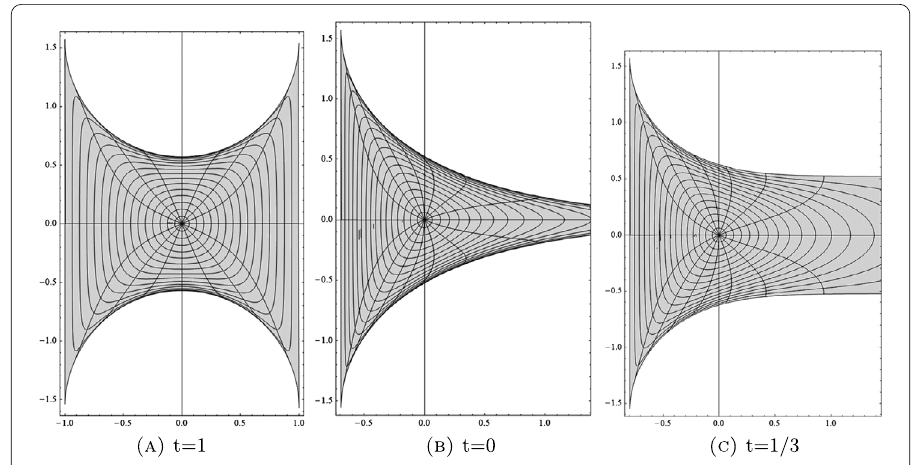
Figure 1 Images of D under f at different values of